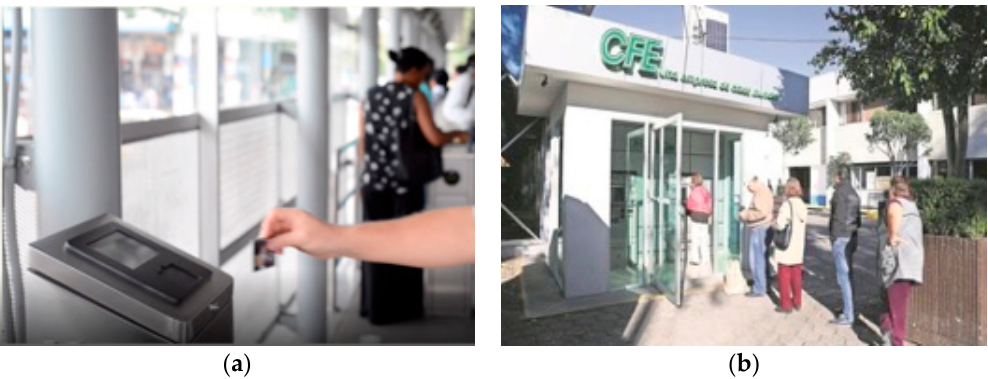
Figure 25. Left image ( a ) Mio, a public bus transportation machine in Cali. Bad placed, weather conditions can affect machine performance. Right image ( b ) a CFE-Matic ATM in Mexico City used for paying electricity bills. Too much direct sunlight makes using the interface very complicated.